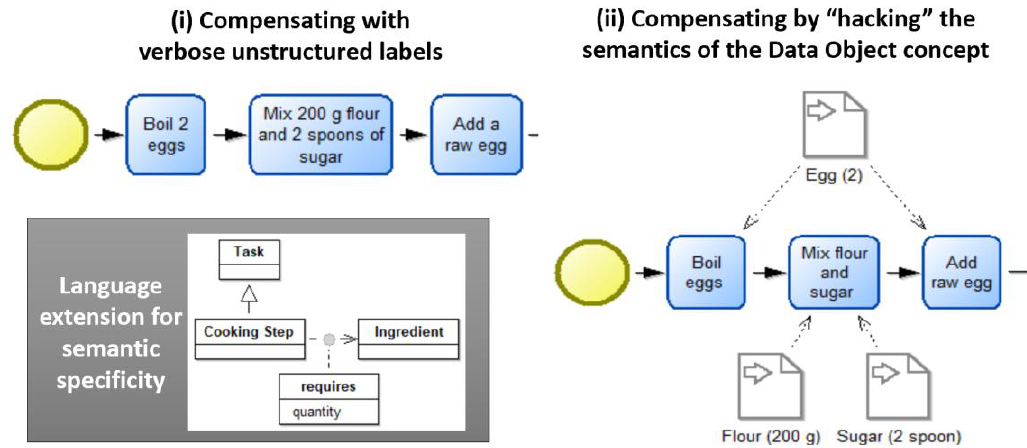
Figure 2. Compensating for the lack of domain-specific expressivity –